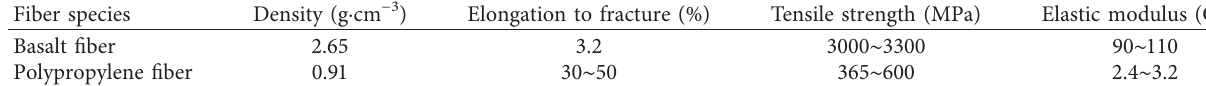
Table 1: Physical and mechanical properties.